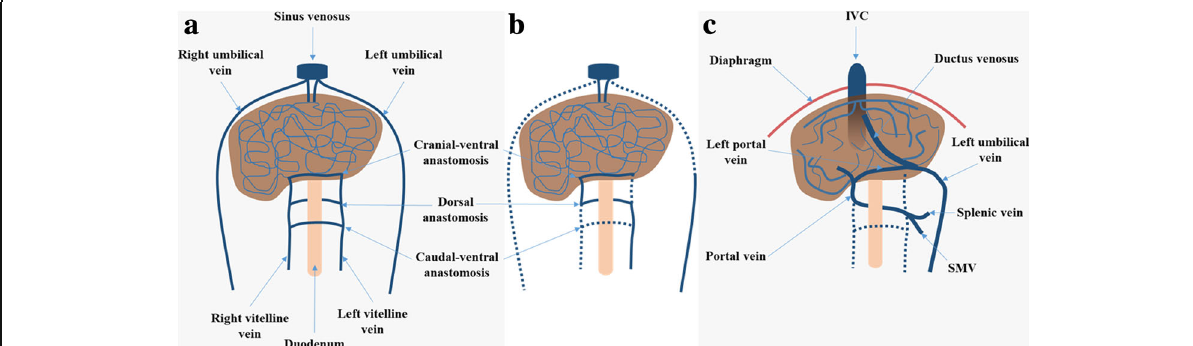
Fig. 1 Diagrammatic representation of the embryological development of the PV. a The vitelline venous system arrives at the primitive liver as two paired veins (right and left), branches into the hepatic sinusoids, and then coalesce, pierce the septum tranversum (primitive diaphragm) and drain into the sinus venosus (primitive heart). These two vitelline veins communicate through three pre-hepatic anastomoses around the developing duodenum (cranial-ventral, dorsal, and caudal-ventral). b Over time, a selective involution occurs, involving the caudal part of the right vitelline vein, the cranial part of the left vitelline vein, and the caudal-ventral anastomosis. The dorsal and cranial-ventral anastomoses persist and give rise to the main PV and to the left PV, respectively. Initially, the paired umbilical veins lie more lateral than the vitelline ones, and also pierce the septum tranversum and drain into the sinus venosus . With the development of the liver, the umbilical veins fragment and connect to the hepatic sinusoids. Over time, a selective involution of the right umbilical vein and cranial portion of the left umbilical vein also occurs. c The remnant left umbilical vein cranially bifurcates, forming two new communications: one with the IVC through the ductus venosus , carrying oxygenated blood from the placenta directly to the fetus; and another with the left PV, supplying directly the liver. After birth, the ductus venosus and the left umbilical vein involute and become the ligamentum venosum and ligamentum teres , respectively